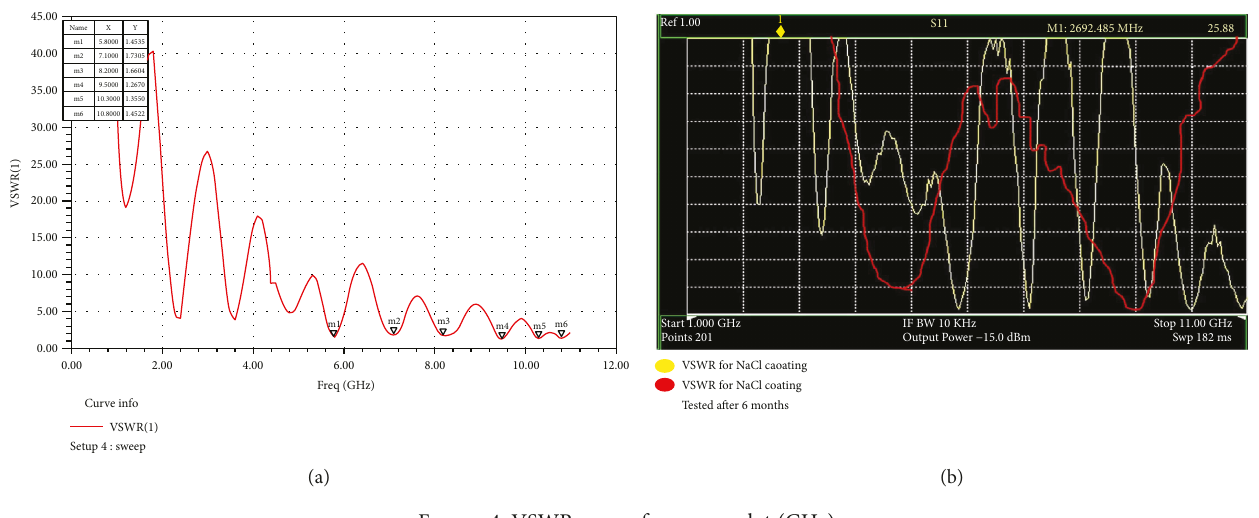
Figure 4: VSWR versus frequency plot